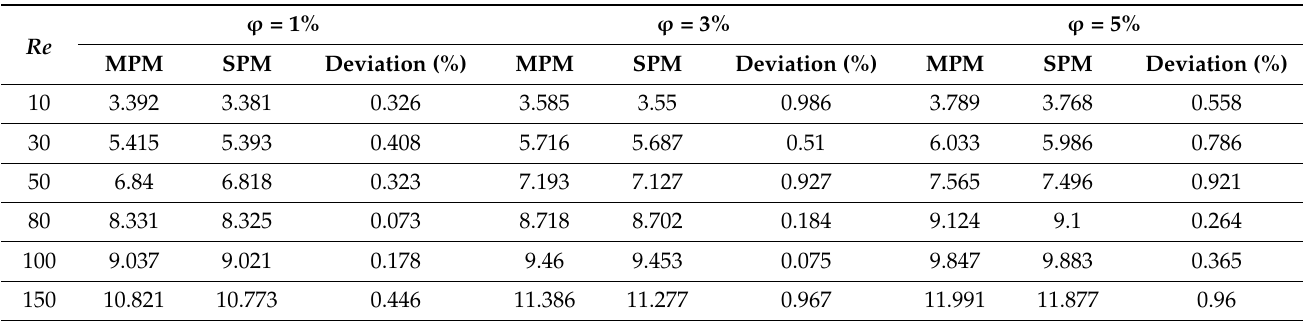
Table 4. Nusselt number ( Nu M deviation between single-phase modelling and multi-phase modelling approaches at Ri =